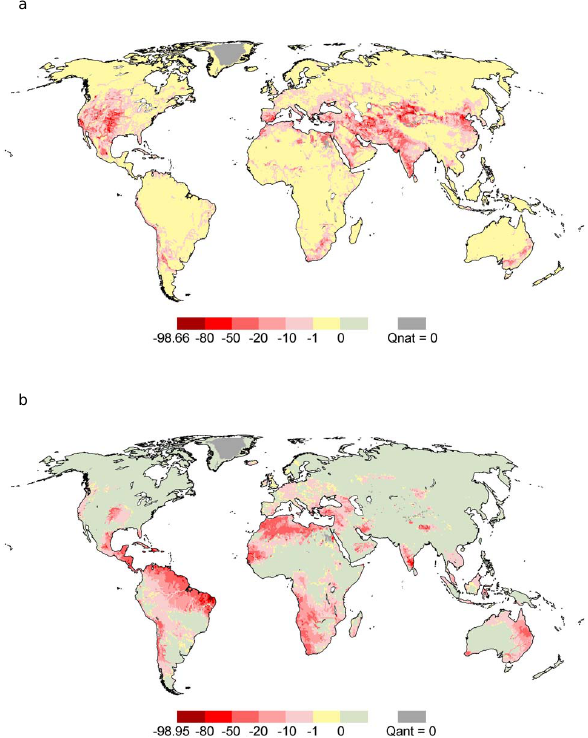
Fig. 6. Impacts on number of fish species. Impact of dams and withdrawals on number of fish species upstream of grid cells (ANT – NAT, in % of NAT) (a) , and impact of climate change on num- ber of fish species upstream of grid cells (CC-ANT – ANT, in % of ANT) (b) . Withdrawals and dams in the year 2002, climate change between 1961–1990 and 2041–2070 according to the emissions sce- nario A2 as implemented by the global climate model